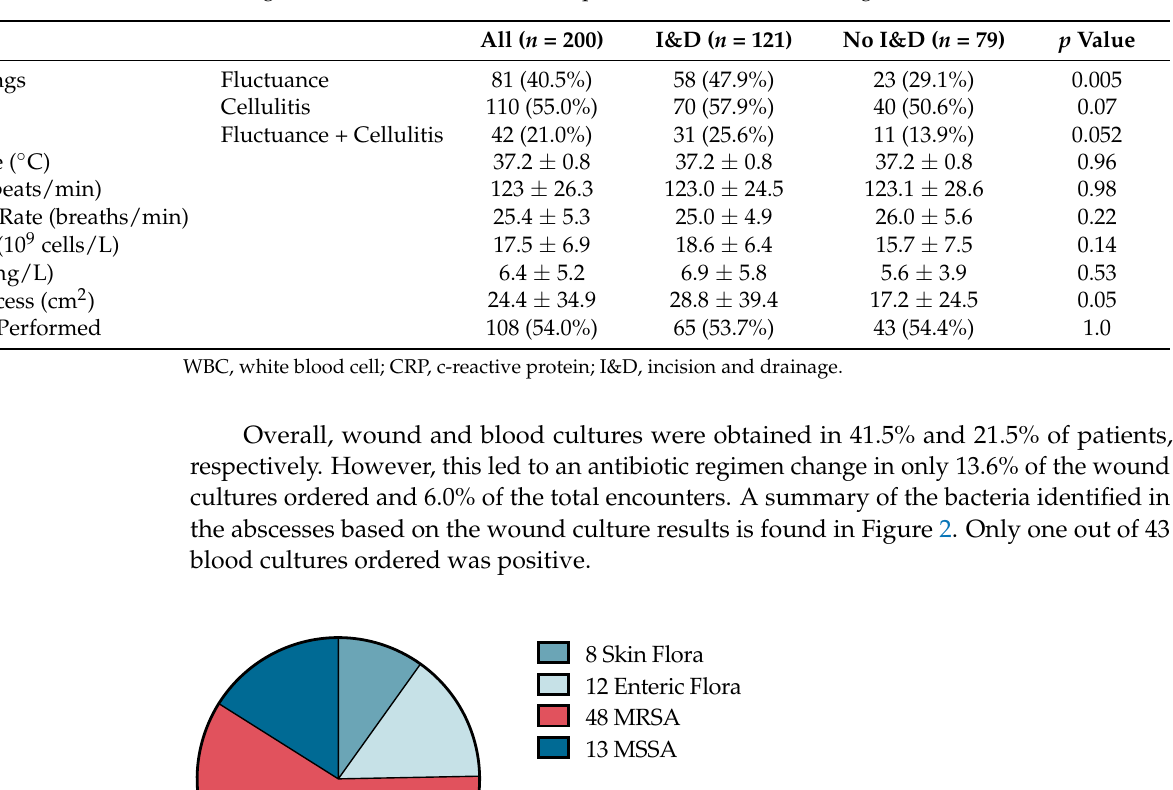
Figure 1. Abscess area correlates with white blood cell count. A scatter plot representing the area of the abscess (cm 2 ) corresponding to the white blood cell count (10 9 cells/ µ L) with a linear trendline (R 2 = 0.0009). The area of the abscess was calculated using the dimensions provided by ultrasonography when available. If no dimensions on ultrasonography were available, the area was calculated using the dimensions of induration and erythema, and the abscess was assumed to be the shape of a square when a length and width were provided. Table 2. Diagnostic factors associated with operative incision and drainage.